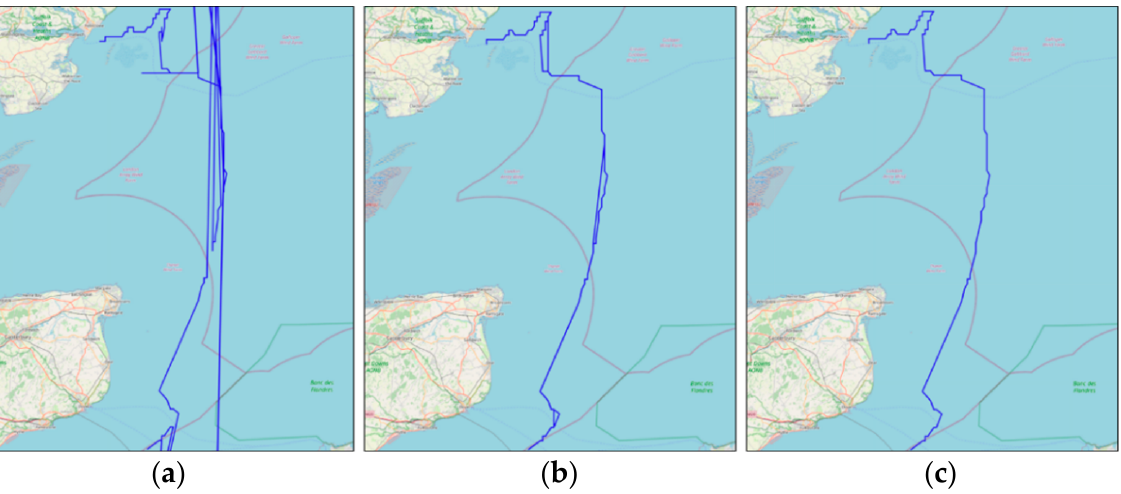
Figure 16. Comparison of denoising effects of MMSI 244554000. ( a ) Data preprocessing; ( b ) data cleaning; ( c ) trajectory reconstruction.